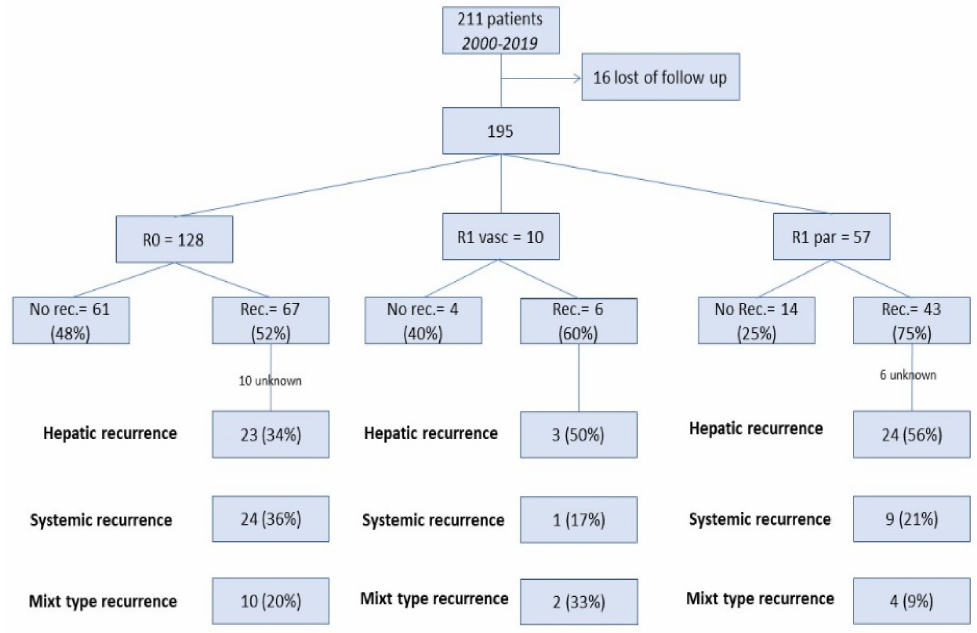
Figure 3. Outline of study